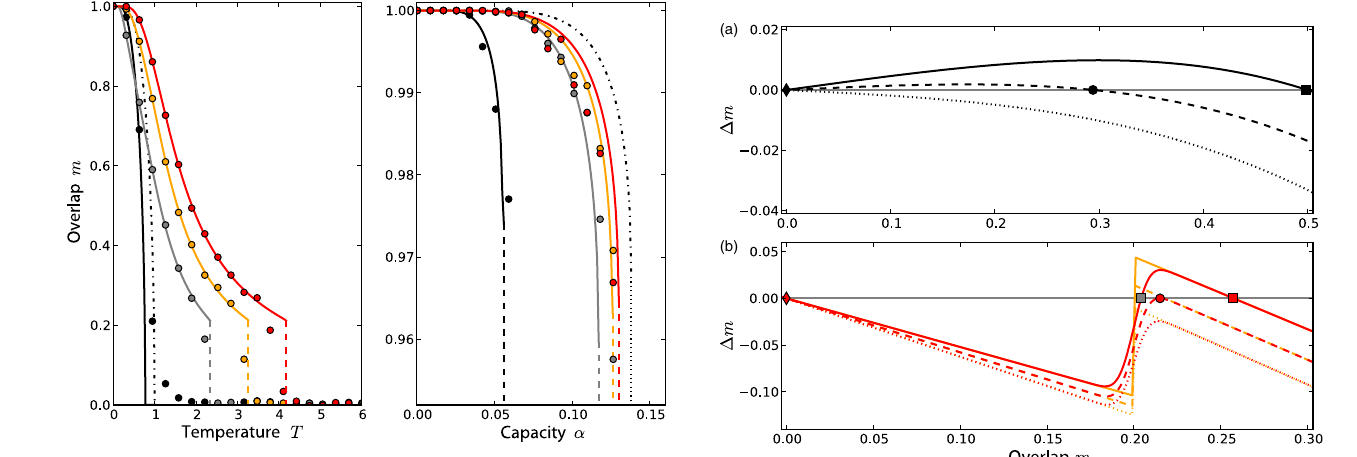
FIG. 6. Graphical solutions to the transcendental equation for the overlap m and phase transitions. Parameters are the same as in Fig. 5, with D ¼ 0 . 4 . Equation (30) is solved graphically, with its solutions given by the zero crossings of Δ m , i.e., the intersections with the solid gray line. (a) For the traditional Hopfield case with linear input summation, the stable solution for the overlap m continuously decreases (black markers, rectangle to circle to diamond) with increasing temperatures T ∈ f 0 . 7 ; 0 . 75 ; 0 . 8 g (solid, dashed, and dotted black lines) and reaches m c ¼ 0 (diamond) at a critical value of T c ≈ 0 . 8 . (b) For nonlinear input summation due to nonlinear dendrites and small α ¼ N − 1 ≈ 0 , increasing temperatures T ∈ f 2 . 0 ; 2 . 295 ; 2 . 6 g (solid, dashed, and dotted red lines) lead to decreasing overlaps m (red markers, from rectangle to circle to diamond) that jump discontinuously from m ≈ 0 . 22 (circle) to zero at T ≈ 2 . 3 . The gray rectangle c c indicates an unstable solution. In the limit α ¼ 0 (orange lines) the jump in Δ m is discontinuous, which slightly changes the critical temperature but leaves the system ’ s critical behavior